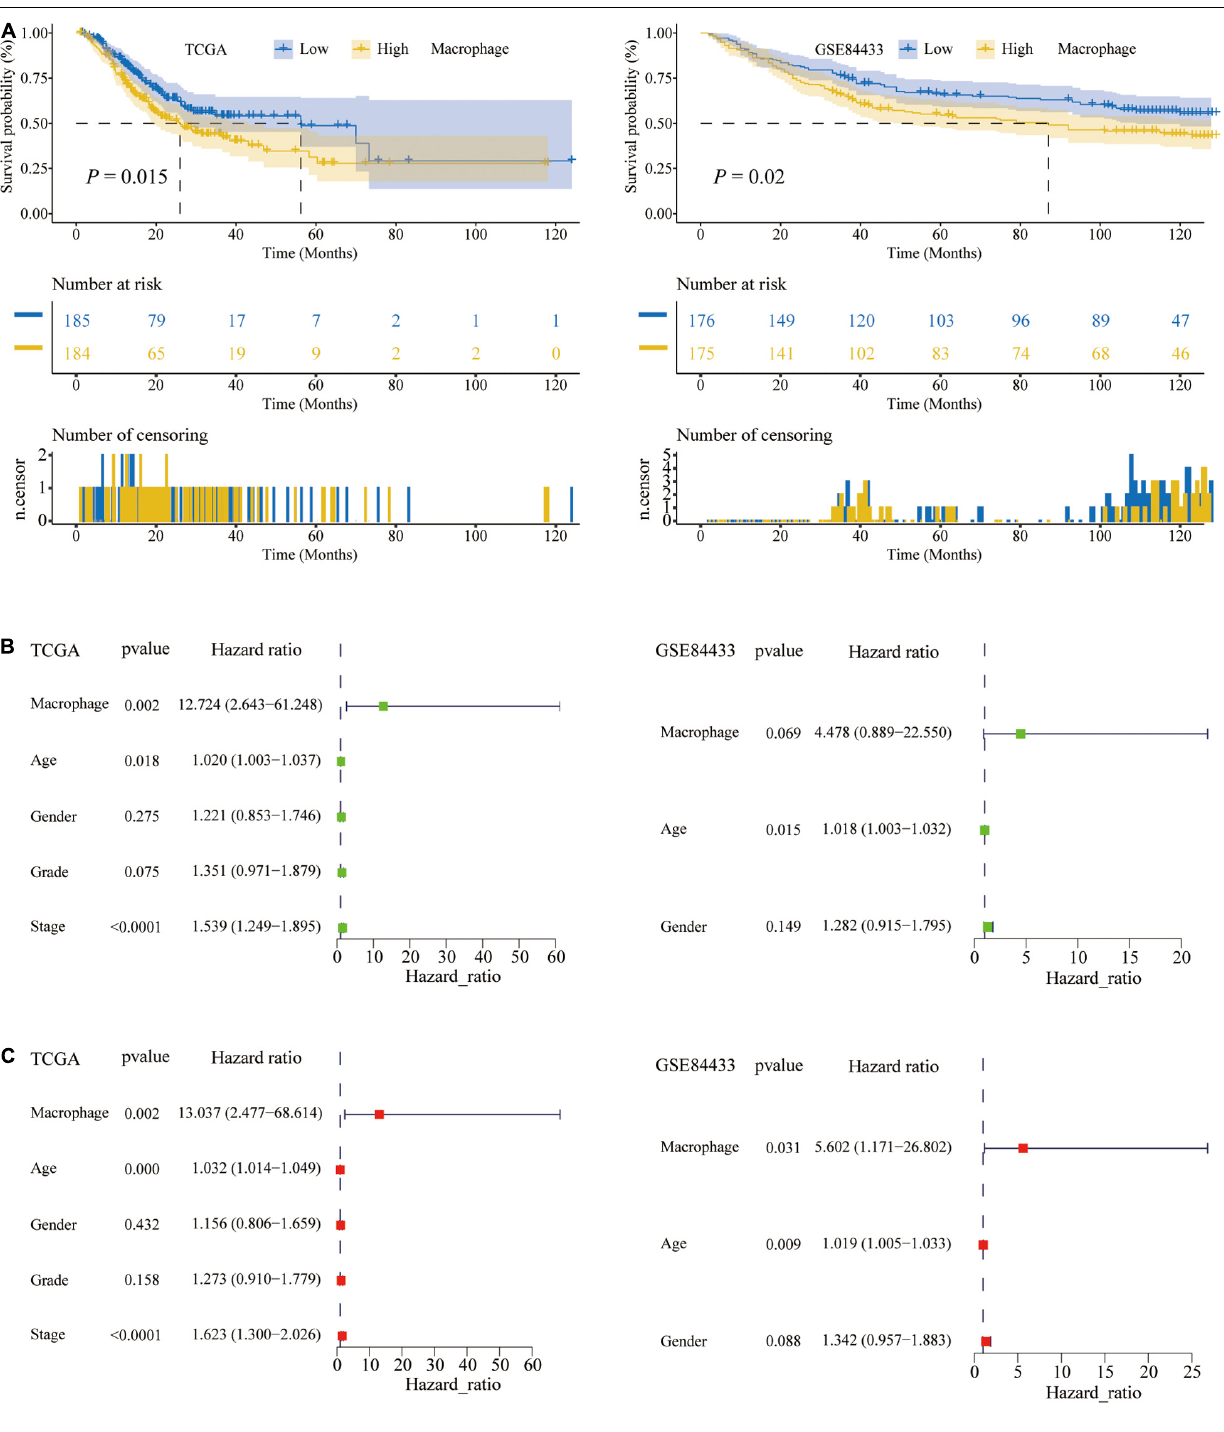
patients and the efficacy of immunotherapy (Waniczek et al., 2017; Li et al., 2020c). The prognostic and therapeutic effects of tumor-infiltrating immune cells in stomach adenocarcinoma